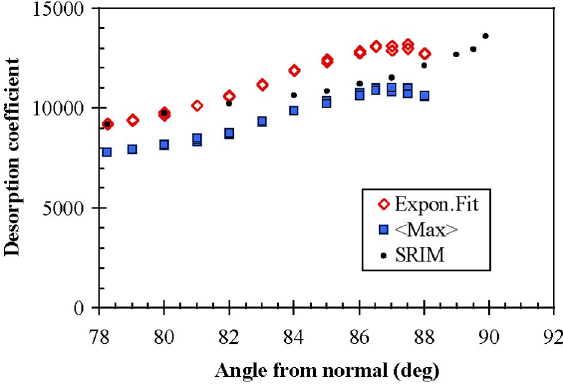
FIG. 14. (Color) Gas desorption coefficient as a function of angle of incidence measured from normal for a baked target. Open red diamonds represent the exponential fit to the ion gauge current evaluated at t (cid:4) 0 , the solid blue squares repre- sent the peak pressure excursion measured by the ion gauge current. The filled black circles represent the effect of ion backscatter as predicted by the SRIM code, if desorption is independent of